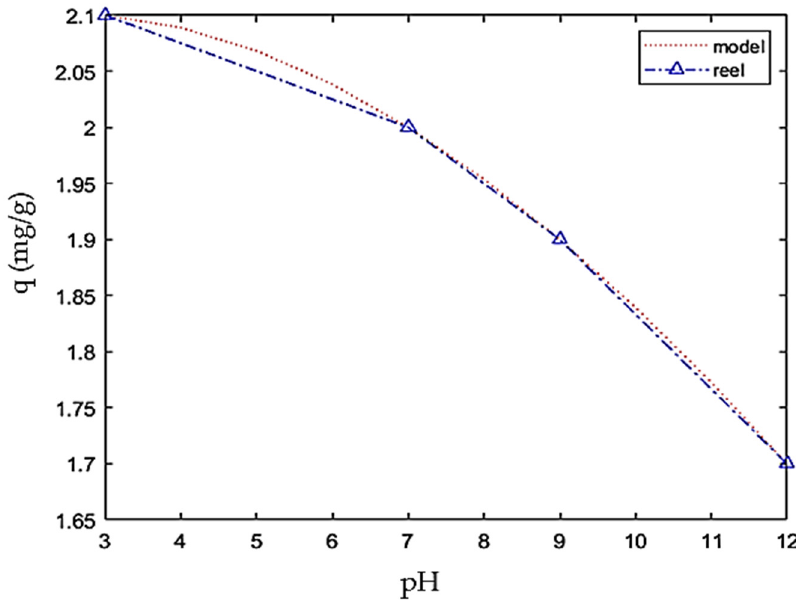
Figure 6. Comparison between the mathematical model (Equation (3)) and the observed results.